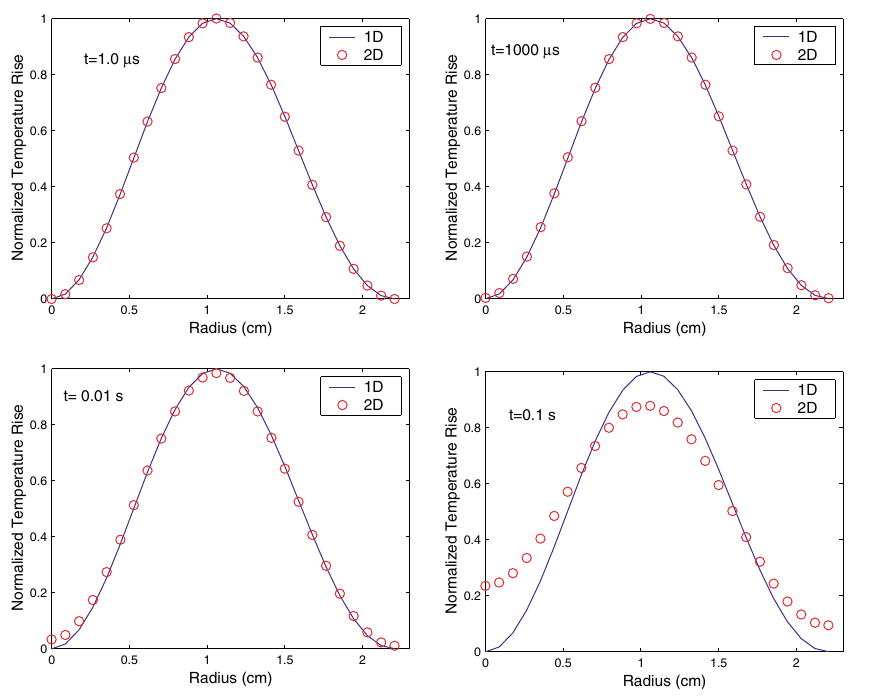
FIG. 11. (Color) 1D and 2D temperature rises of the cavity end caps for various pulse lengths normalized to the maximum temperature rise for